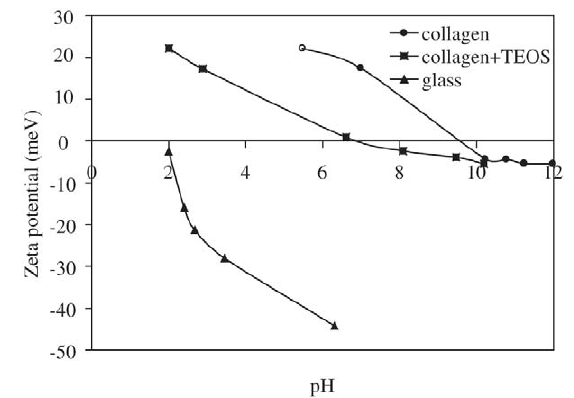
Figure 5. Zeta potencial ( ξ ) of collagen, TEOS-treated collagen, and